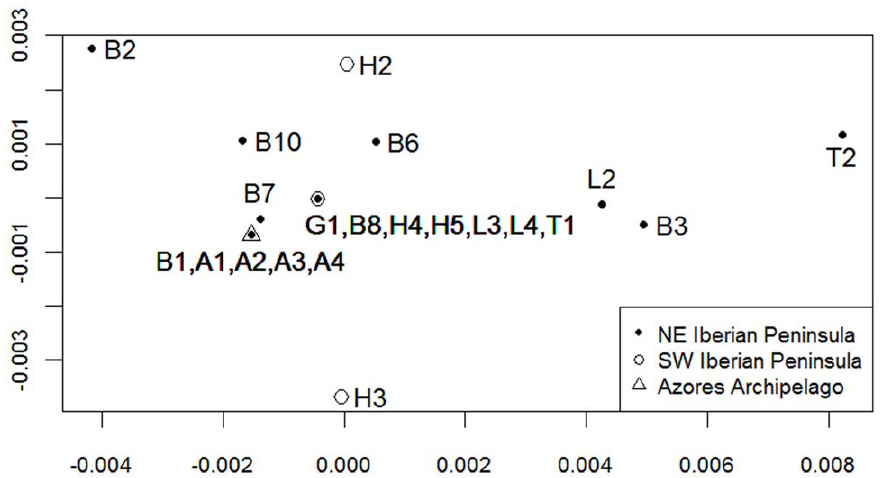
Figure 2. Multidimensional scaling of the genetic distances between the analysed individuals. Values in the axes are coordinates generated to provide a two-dimensional representation of the genetic dissimilarity between the Taenia pisiformis CO I sequences (individual codes correspond with those in Table 1, province initials with Figure 1). The symbols represent their main regions of origin.